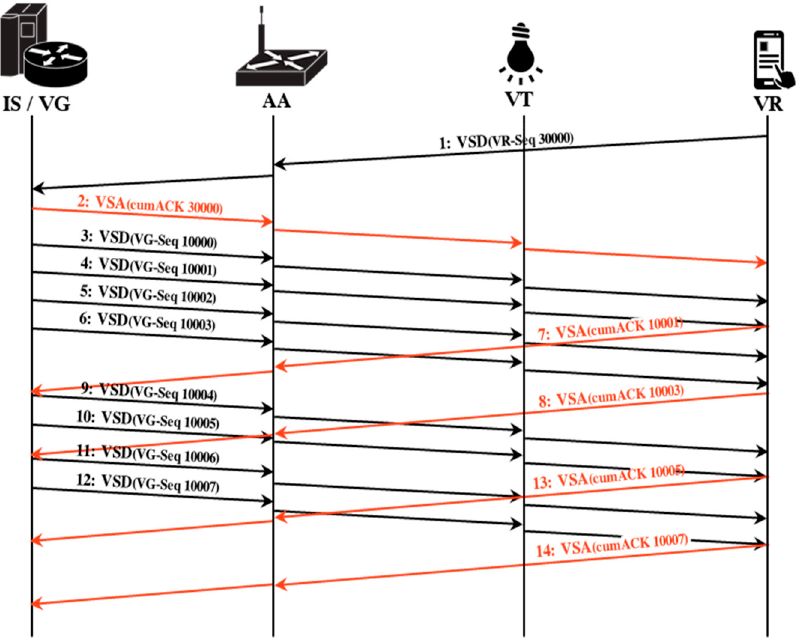
Figure 11. Data transmission operations.